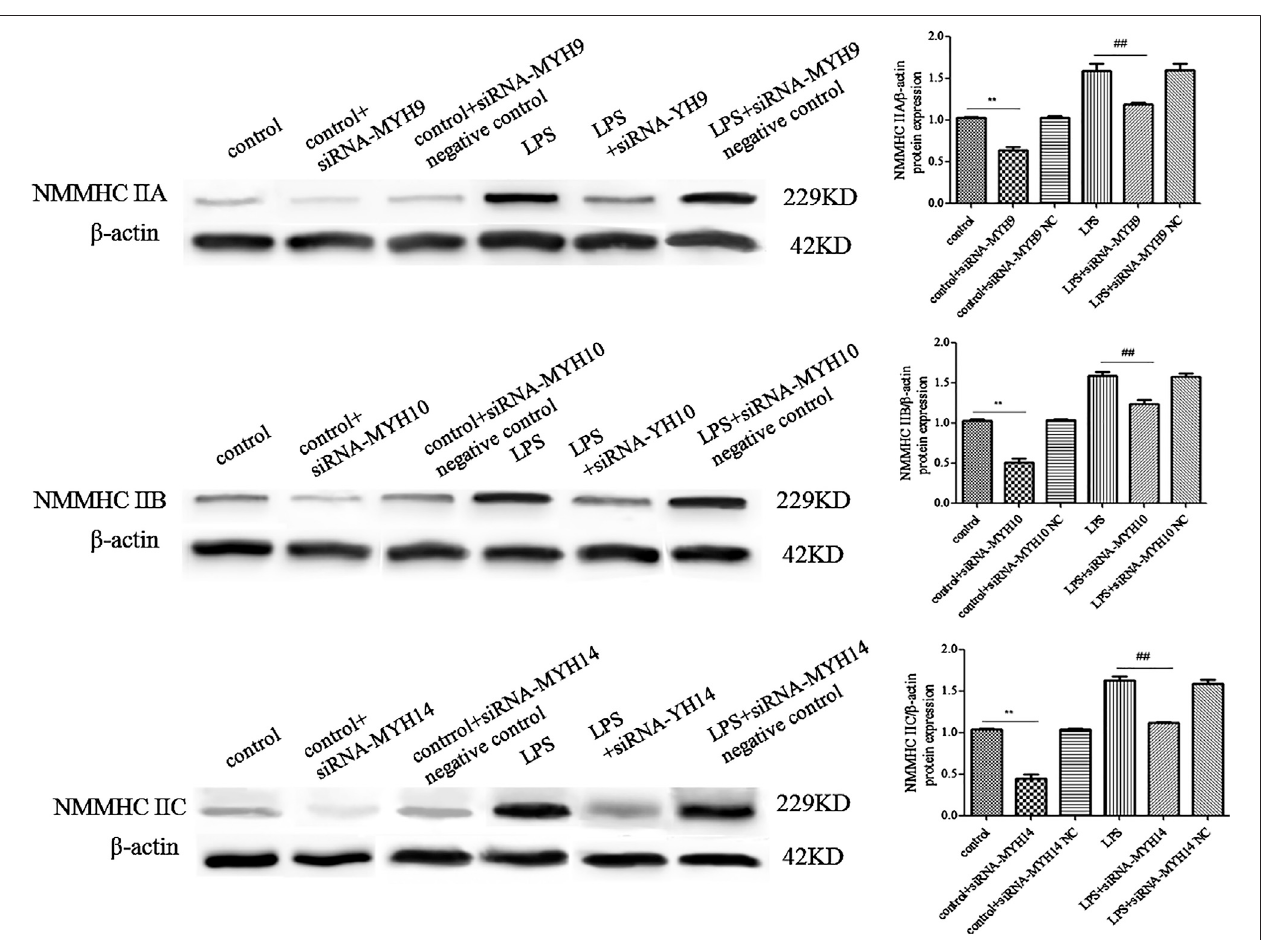
FIGURE 3 | Detection of NMMHC Ⅱ A, NMMHC Ⅱ B, and NMMHC Ⅱ C in exosomes extracted from microglial cells. For transfection, microglial cells were sub- cultured in 24-well plates at a density of 3 × 10 5 cells/ml. Cells were transfected with siRNA-MYH9, siRNA-MYH10, or siRNA-MYH14 at a fi nal concentration of 100 nM for 48 h. The extracted exosomes were grouped based on whether they were extracted from control microglial cells, microglial cells transfected with siRNA, microglial cells transfected with siRNA negative control, microglial cells stimulated by 1 mg/ml LPS for 24 h, microglial cells transfected with siRNA followed by 24 h LPS stimulation, or microglial cells transfected with siRNA negative control followed by 24 h LPS stimulation. The NMMHC Ⅱ A, NMMHC Ⅱ B, and NMMHC Ⅱ C protein expression levels for each group of exosomes were examined by western blotting. Western blots were quanti fi ed. Nine independent experiments were analyzed. A histogram depicted thequantitativerepresentations oftheprotein expression levels ofCD9and CD81 foreach group. Thedatawereaverages withSD, n (cid:2) 9. ** p < 0.01 vs. control microglial cells; ## p < 0.01 vs. microglial cells stimulated with LPS.